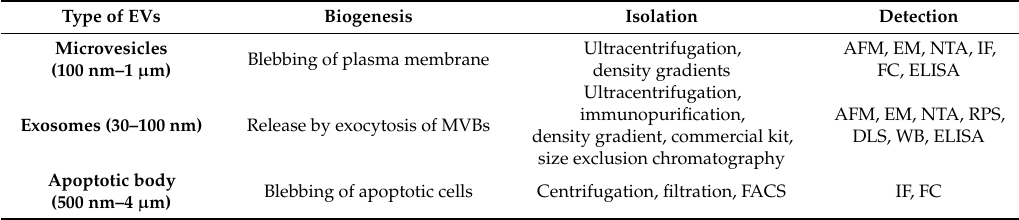
Table 1. Methods for the isolation and the characterization of MVs and